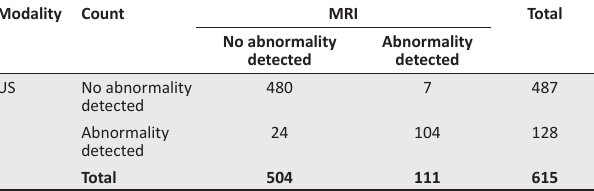
TABLE 3: Abnormalities on ultrasound when compared with magnetic resonance imaging.